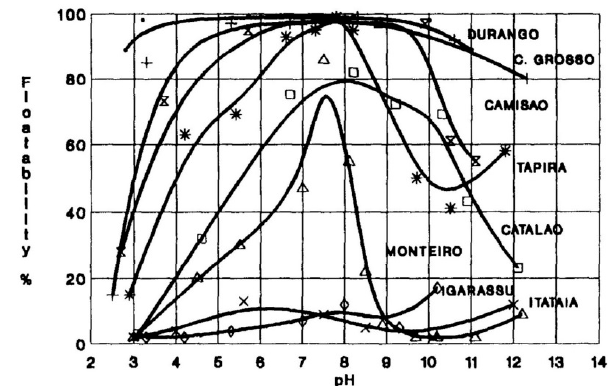
Figure 5. Microflotation curves of various apatite samples using 2.5 × 10 − 5 mol/L sodium oleate [31].